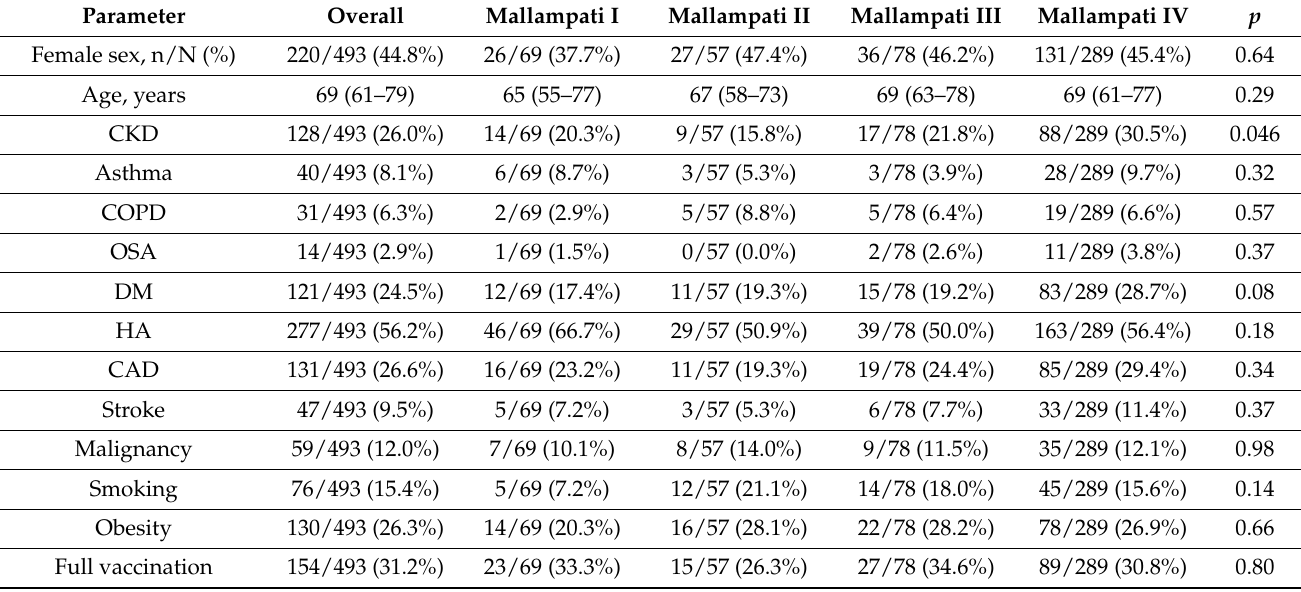
Table 1. Demographic and clinical characteristics at baseline.